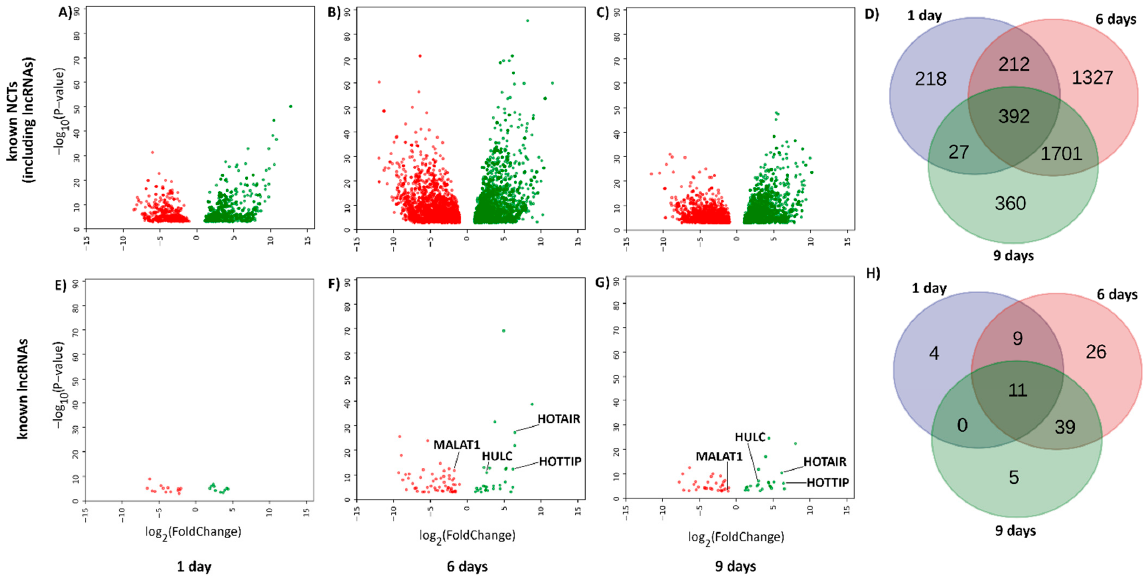
Figure 2. Differentially expressed putative known non-coding RNAs after MC-LR exposure. ( A – D ) Volcano plots and Venn diagram of differentially expressed (DE) transcripts with homology to any transcript deposited in the Rfam database (including lncRNAs). ( E – H ) Volcano plots and Venn diagram of DE transcripts with homology to transcripts labeled as lncRNAs in the Rfam database. Data points represent downregulated (red) or upregulated (green) putative known ncRNAs. Expression of putative metastasis-associated-in-lung-adenocarcinoma transcript-1 (MALAT1) transcript was downregulated at 6 and 9 days of microcystin-LR (MC-LR) exposure. Thresholds of a log2 fold-change > |2| and an adjusted p -value < 0.001 were used to filter out contigs with the smaller and less statistically significant differences between groups.